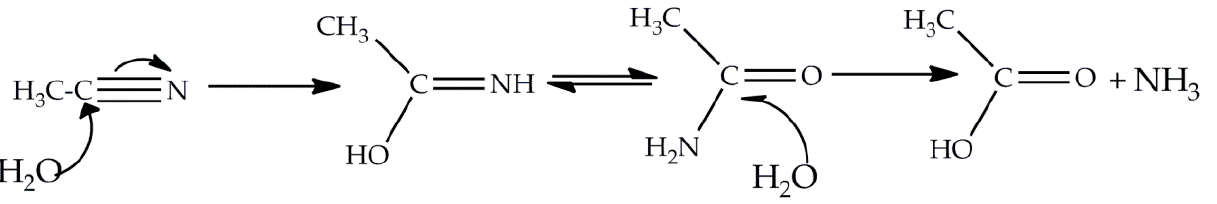
Figure 2. The hydrolysis of MeCN to generate MeCO 2 H.